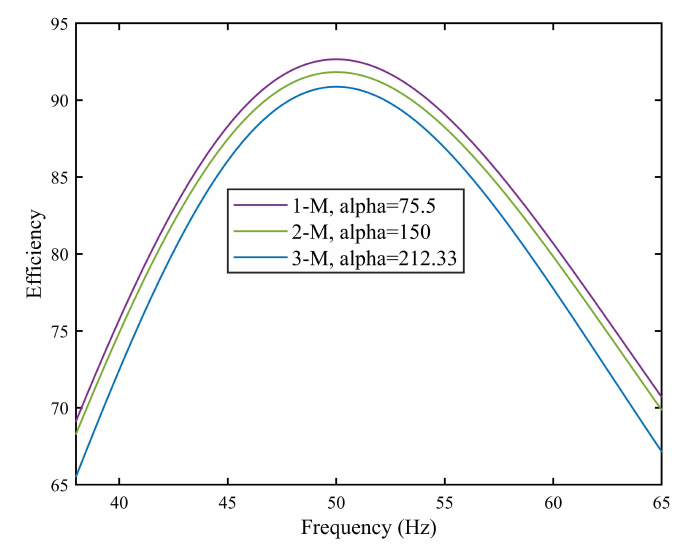
Figure 22. Efficiency of proposed TMM-LOA.